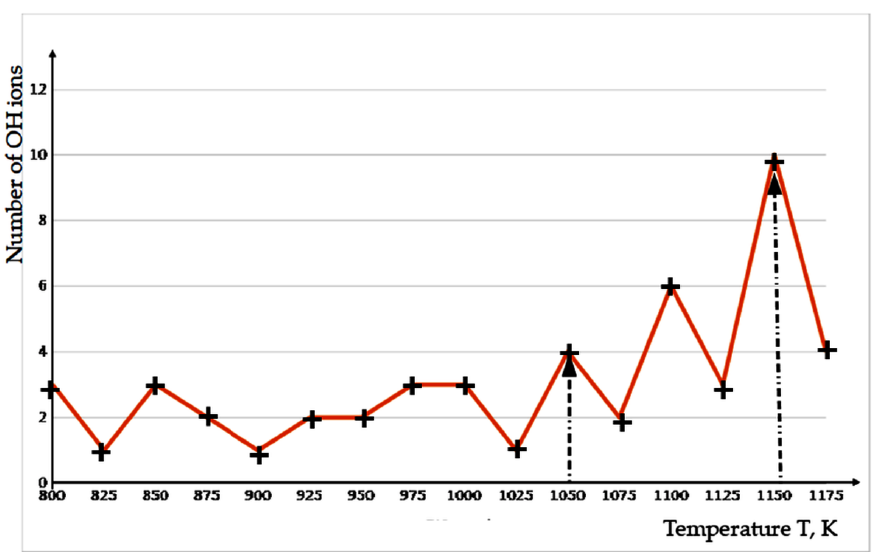
Figure 5. The detached OH ions number during 10 ns relaxation of MDS run at each constant temperature T (the results of the 16 independent MDS runs are shown). The crosses mark the values of the number of detached OH ions at each fixed T, and the line shows their conditional change; 1-st arrow marks the temperature of the beginning of the intensive release of OH ions from the HAP32 cluster; 2-nd arrow marks the temperature with 10 OH ions departure.